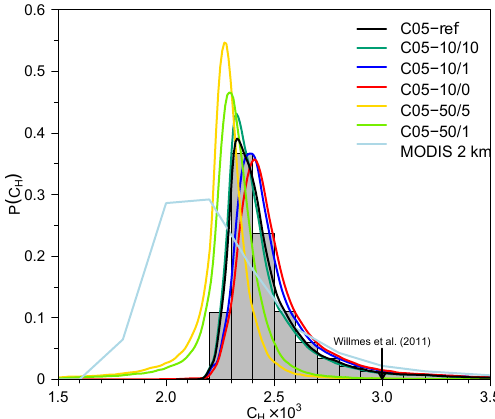
Figure 12. Probability density functions of the turbulent trans- fer coefficients for heat ( C H ) within the Laptev Sea polynyas in the winter period (November–April) 2007/2008, aggregated within the four polynya masks. The grey bars show the histogram of C H from C05-ref. Only values below 6 × 10 − 3 have been used for the construction of this figure. The mean values of the C05 simulations are ≈ 2.5 × 10 − 3 and the standard deviations are ≈ 0.28 × 10 − 3 , except for C05-50/5 and C05-50/1 where the mean values are ≈ 2.27 × 10 − 3 and ≈ 2.31 × 10 − 3 , and the standard de- viations are ≈ 0.18 × 10 − 3 , respectively. The constant value of C H = 3.0 × 10 − 3 of Willmes et al. (2011a) is marked with an arrow. The mean C H value derived from MODIS2km (November–March) is C H = 2.3 ± 0.3 × 10 − 3